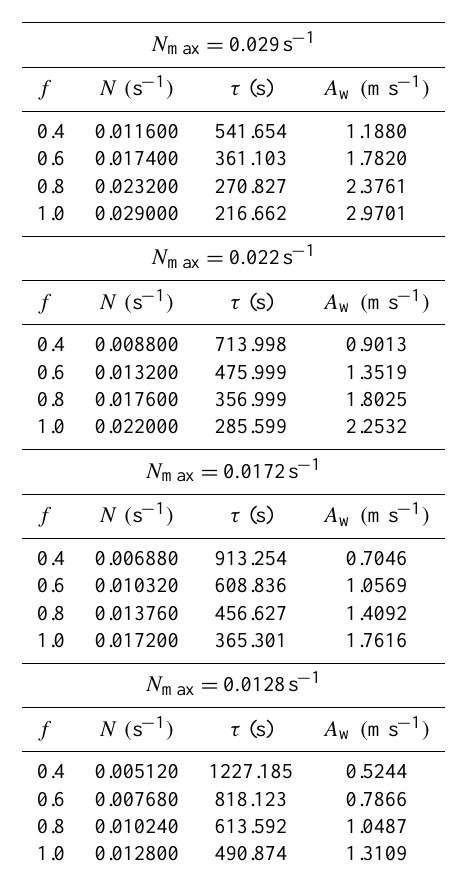
Table A1. Intrinsic frequencies N = f · N max , periods τ = 2 π vertical velocity amplitudes A w = regimes N max using a temperature amplitude of A T = 1K.